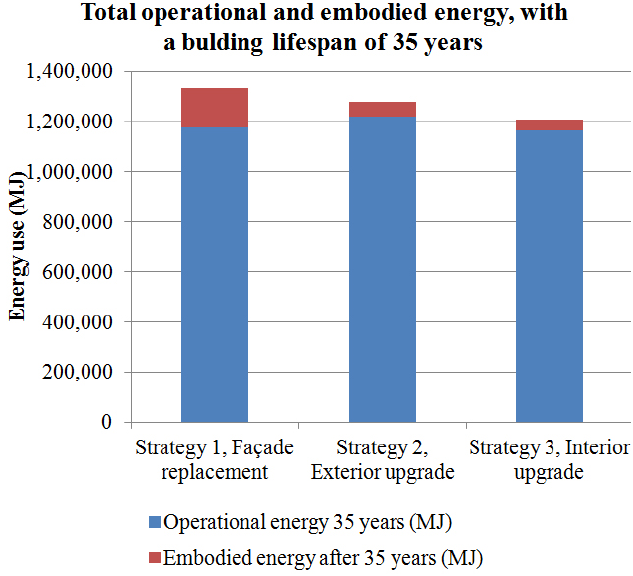
Figure 12. Total embodied and operational energy per strategy for a lifespan of 35 years for the top corner apartment of the case study